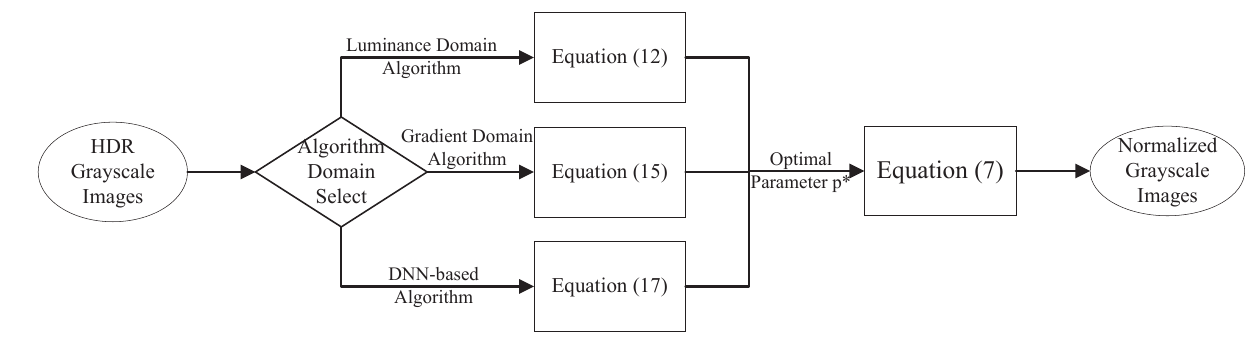
Figure 3. Overall flowchart of the proposed method.